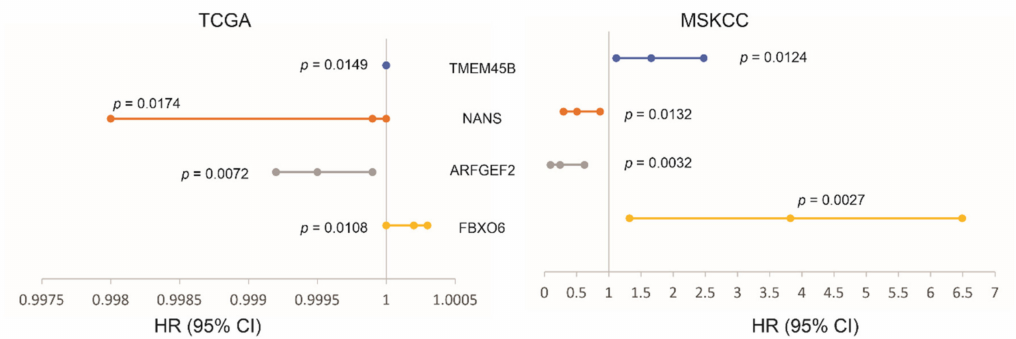
Figure 7. Associations of the indicated LE genes with prostate cancer relapse in The Cancer Genome Atlas (TCGA) PanCancer ( n = 492) and MSKCC ( n = 140) cohorts. Univariate Cox PH (proportional hazard) analyses were performed using R survival package. The PH assumption was violated for FBXO6 in the MSKCC cohort; the assumption for others was confirmed. The FBXO6 expression in the MSKCC cohort was presented as log2 transformed data. HR and 95% CI for TEME45B in the TCGA dataset are 1, respectively.